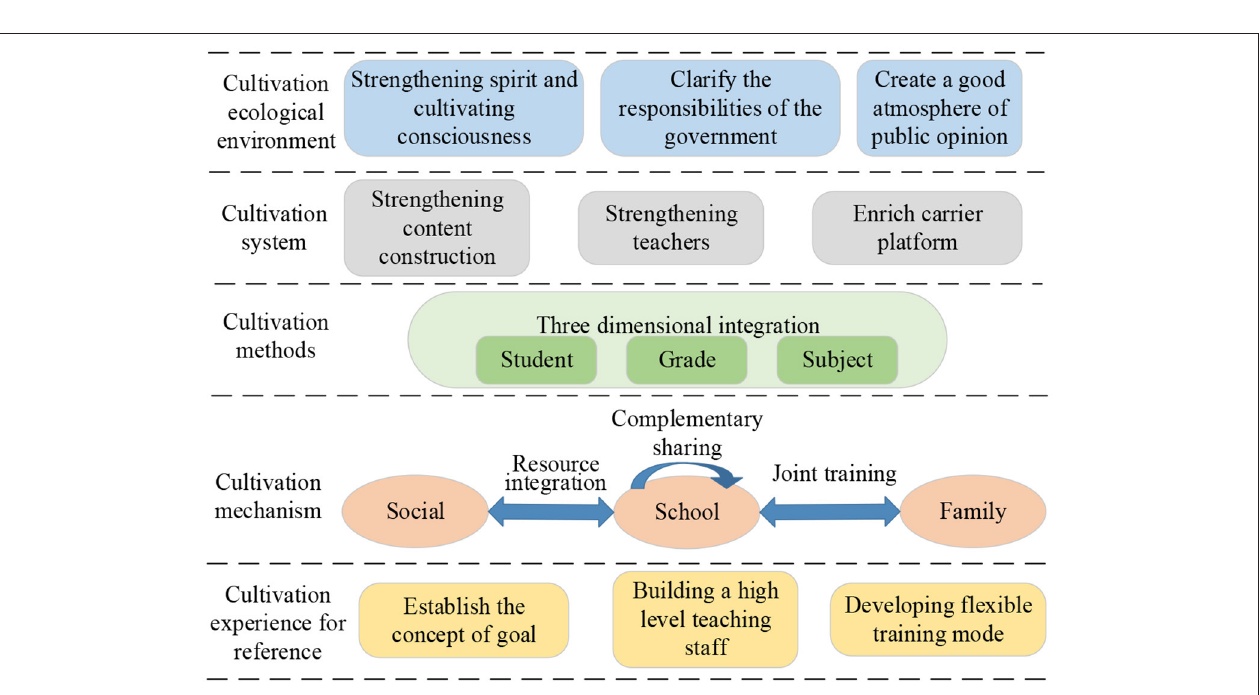
FIGURE 7 | Framework of strategies for constructing college students’ entrepreneurial value